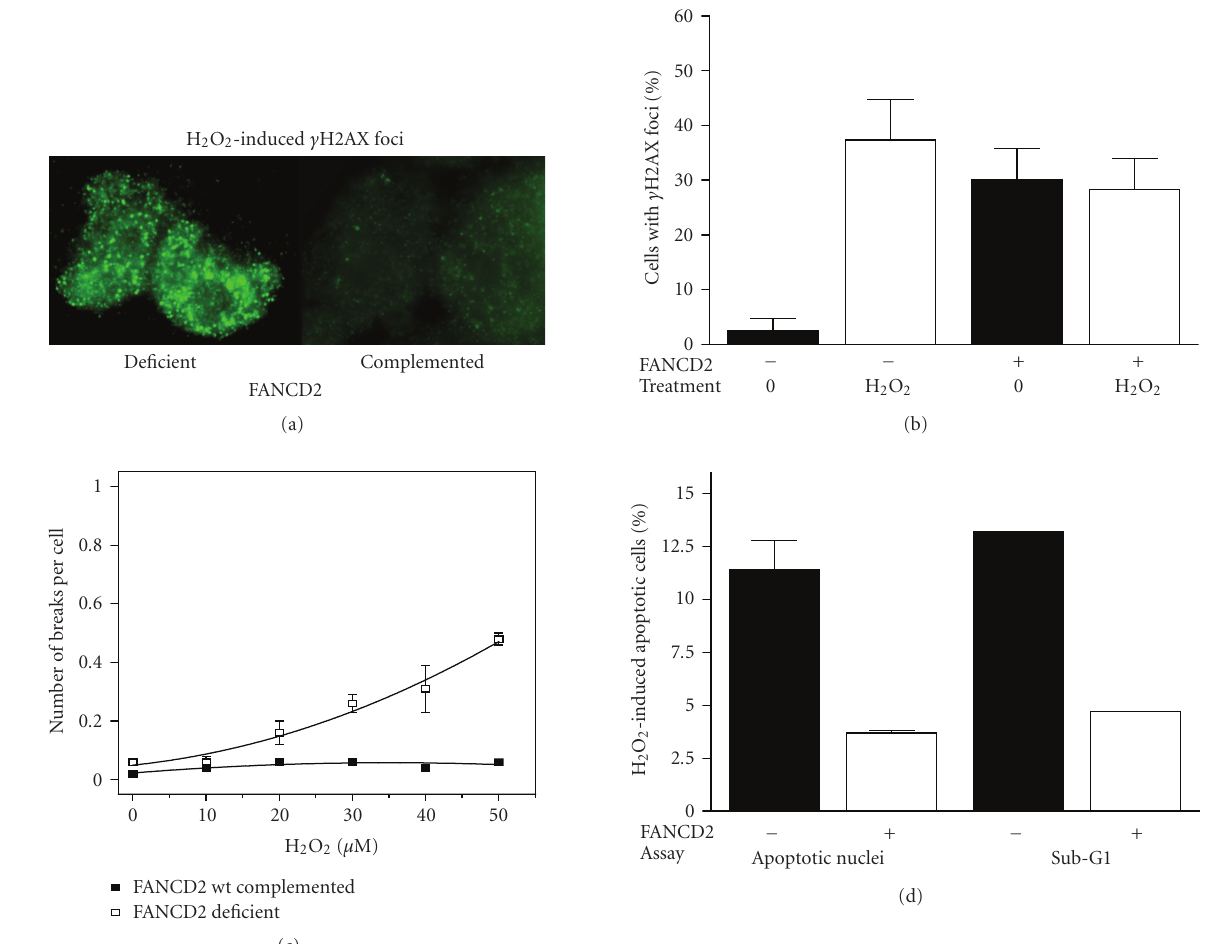
Figure 4: DNA damage and cell survival as a function of FANCD2 status. (a) Representative images of the formation of γ H2AX foci in PD20 versus wild-type complemented cells 30 minutes after completion of H 2 O 2 treatment. (b) Quantification of γ H2AX foci response. Data represent means with upper standard error based on two independent experiments. (c) G2-type chromosomal aberrations are expressed as breaks per cell as a function of increasing H 2 O 2 concentration in FANCD2-deficient and wild-type complemented PD20 cells. Data represent means with SEM based on at least three repeat experiments. (d) Apoptosis induction by H 2 O 2 (50 μ M) in cells with or without wild-type FANCD2 using fluorescence microscopy to assess apoptotic morphology by DAPI staining and flow cytometric analysis for sub-G1 DNA content. Representative experiments based on the apoptotic response at 24 hours are shown (similar results were obtained at 48 hours and with 25 μ M H 2 O 2